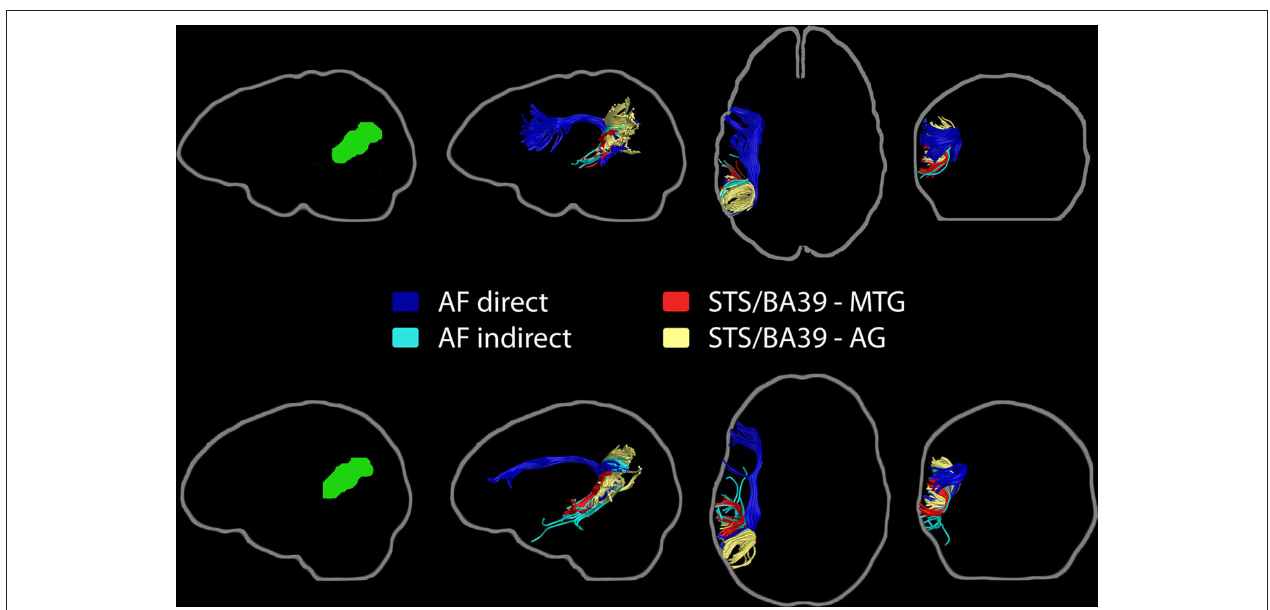
the arcuate fasciculus, with its direct and indirect compartments shown. Short fiber bundles connecting this ROI to the MTG ROI and the angular gyrus are also represented.